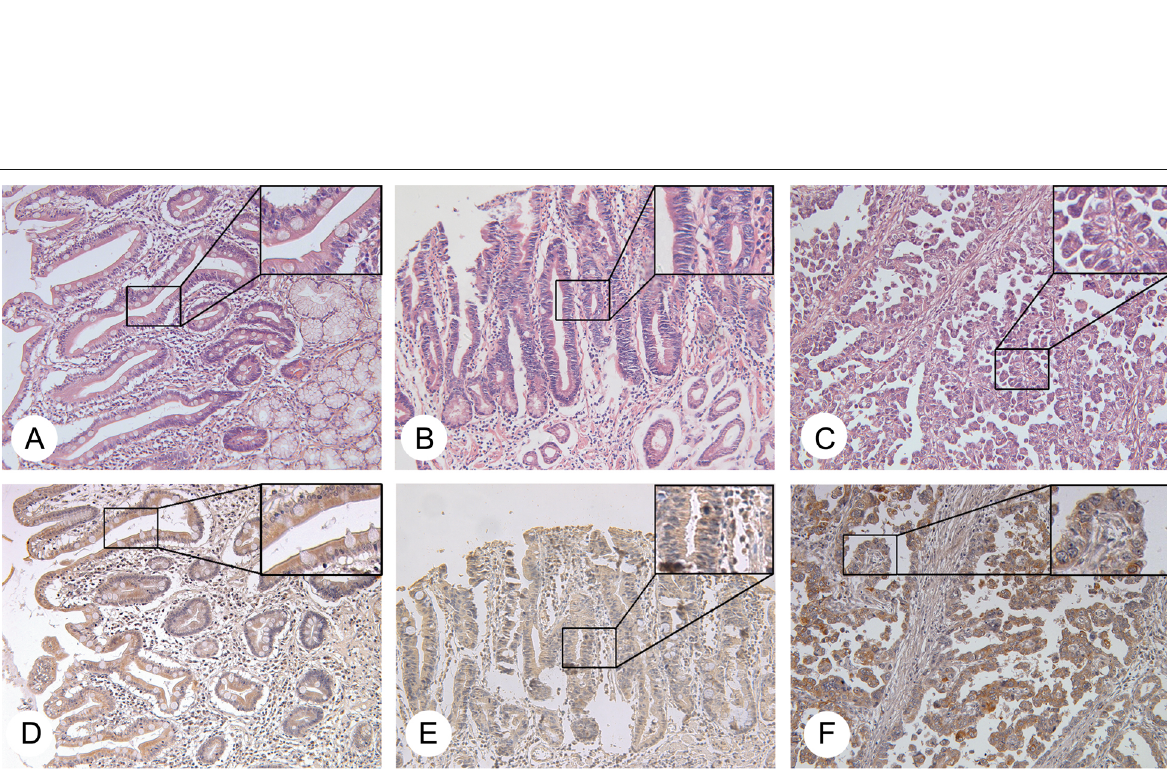
Fig. 3 GCRG213p expression in IM, gastric dysplasia and adenocarcinoma. a - c , h & e staining images in gastric IM ( a ), dysplasia ( b ) and adenocarcinoma ( c ). d - f , representative images of GCRG213p immunostaining in tissue samples from gastric IM ( d ), dysplasia ( e ) and adenocarcinoma ( f ). (Original magnification 200×, and 400× in block